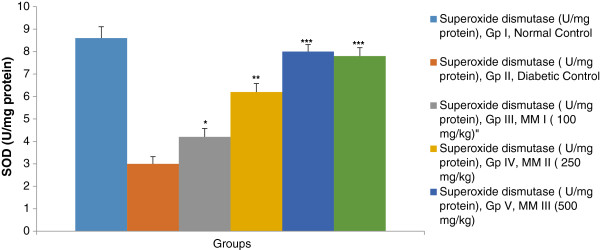
Effect of Melastoma malabathricum Linn. (MM) on superoxide dismutase (SOD) at different concentrations on STZ induced diabetic rats, compared to standard drug Glibenclamide; values are mean ± SEM; n = 6; *P < 0.05; **P < 0.01; ***P < 0.001; P > 0.05 is considered as non-significant (ns).